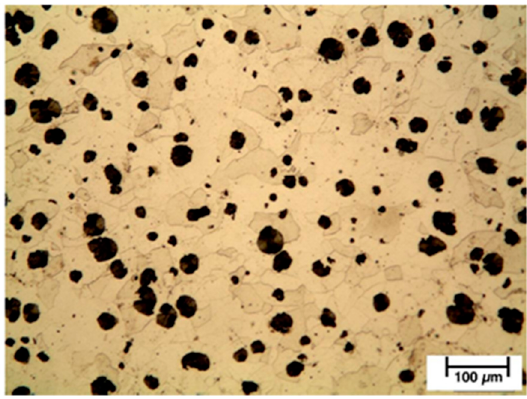
Figure 1. Microstructure of Sibodur ® 450.